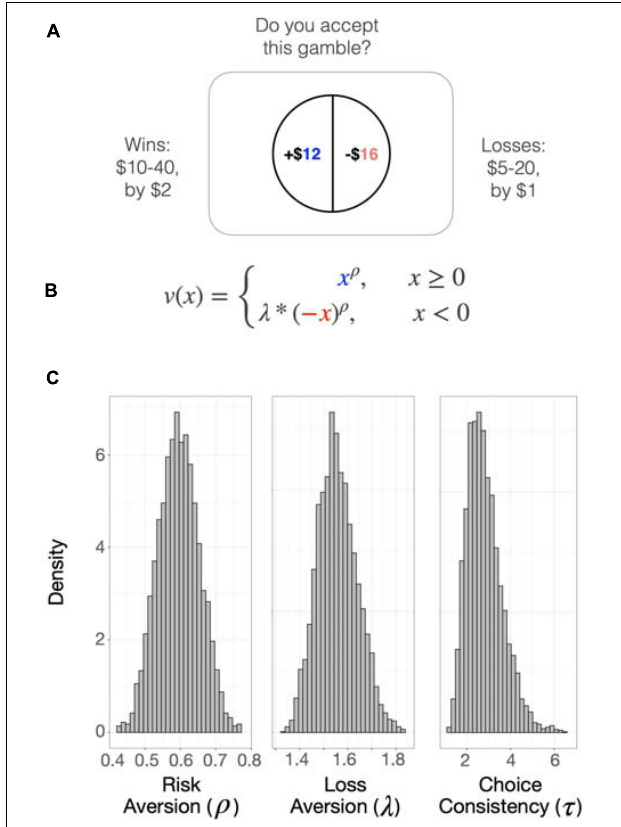
FIGURE 1 | The Loss Aversion Task. (A) The task consisted of 128 sequential monetary choices to accept or reject a mixed gamble offering a 50/50 chance of winning a certain amount of money (blue) and losing a different amount of money (red). On each trial, an image representing a 50/50 choice was presented on the screen, and the participants indicated whether they strongly accept, weakly accept, weakly reject, or strongly reject the choice. Before testing, participants received thorough instruction and practice on how to perform the task. One choice was randomly selected to be paid out at the end of the task. (B) . Gain ( x ) and loss ( –x ) magnitudes of each choice were inserted into the subjective value equation v(x) . The loss aversion parameter ( λ ) represents the sensitivity to potential loss relative to potential gain. Rho ( ρ ) describes the curvature of the utility function and represents attitude toward risk. (C) Posterior distributions of parameters estimated using hierarchical Bayesian analysis, which enables the joint estimation of individual and group parameters. The distribution densities of each parameter are plotted. Higher values of λ indicate higher loss aversion and that the participant assigns more weight to losses than to gains of equal magnitude. When ρ < 1, the participant is risk-seeking for losses (more likely to take a gamble over a sure loss) and risk-averse for gains (more likely to choose a sure gain over a riskier prospect). The opposite is true when ρ > 1. Tau ( τ ) is the logit sensitivity and represents choice consistency, or the sensitivity of the participant to the difference between the certain amount and the